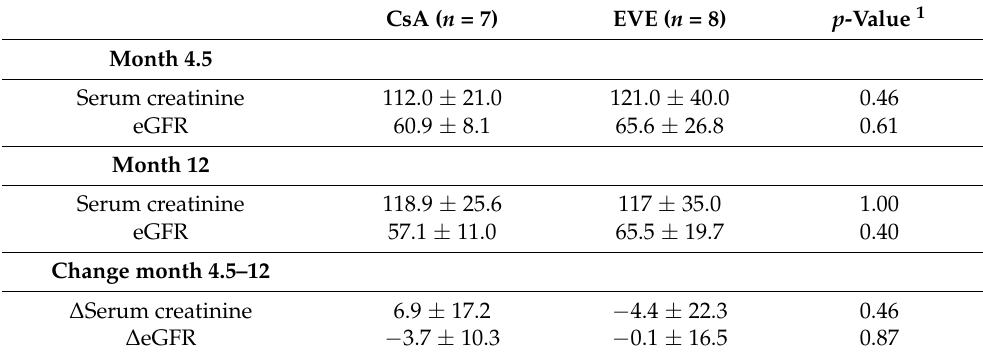
Table 8. Mean serum creatinine values and estimated glomerular filtration rate according to medica- tion group and